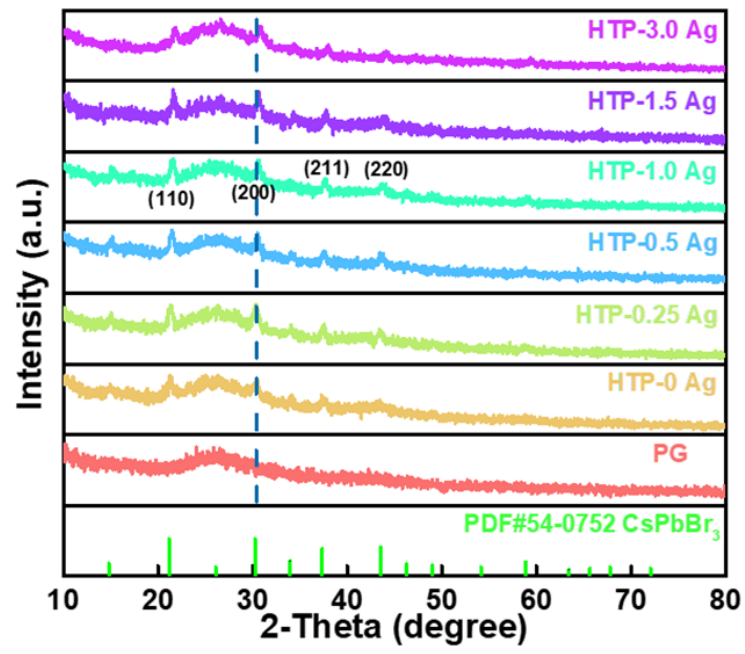
Figure 3. XRD patterns of PG and CsPbBr 3 QD-doped glasses containing Ag NPs.